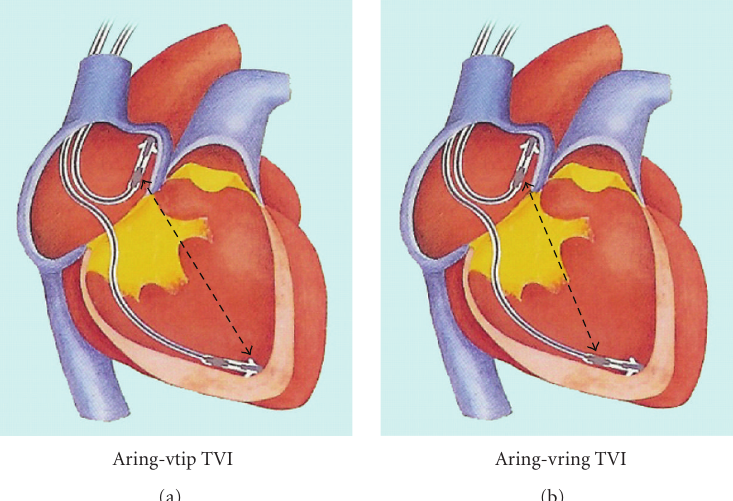
Figure 3: Trans Valvular Impedance (TVI) system (Medico, Italy). The impedance signal is derived between right atrium and the ventricle, by the tip (a) or the ring (b) electrodes of standard pacing leads.